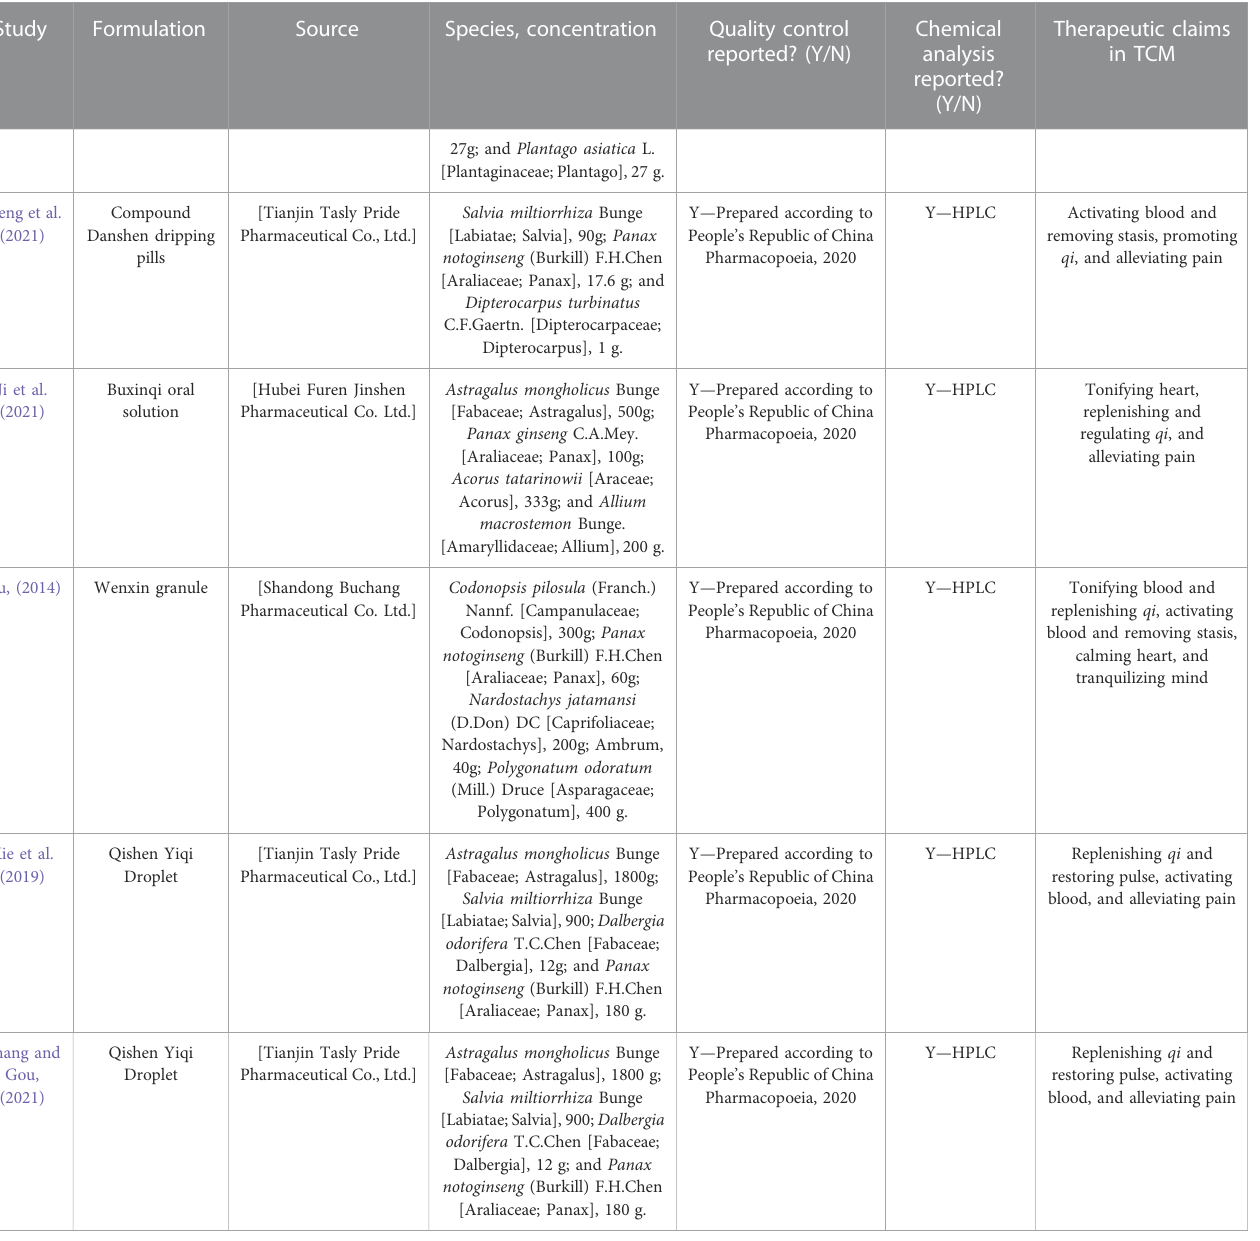
TABLE 2 ( Continued ) Summary of composition of